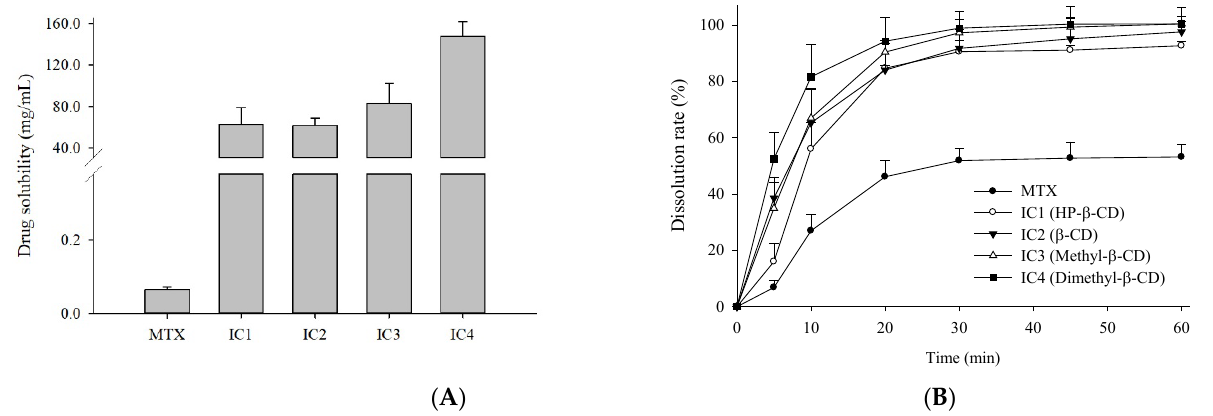
Figure 2. ( A ) Solubility and ( B ) dissolution profiles of MTX and the four different MTX-CD inclusion complex formulations; MTX/HP- β -CD inclusion complex (IC1); MTX/ β -CD inclusion complex (IC2); MTX/M- β -CD inclusion complex (IC3); MTX/DM- β -CD inclusion complex (IC4) in aqueous media. Each value represents the mean ± SD ( n = 3).